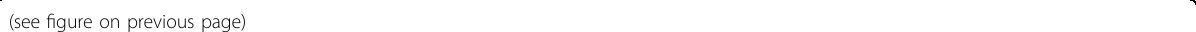
Fig. 4 Maternal PRS- and drug-induced changes in F1 offspring behavior under low- and high-stress testing conditions. a In the OF (left), male F1-PRS rats spend less time in the center of the OF compared to F1-C, regardless of maternal drug treatment (center ; 2 × 3 ANOVA, group F 1,83 = 7.6, p < 0.01), while female offspring are unaffected by maternal PRS or drug treatment (right). b In the NOR task (left), PRS decreases overall exploration time in males (center; 2 × 3 ANOVA, group, F 1,75 = 4.45, p < 0.05), but increases it in females, and the latter effect is reversed by maternal treatment with either NBI or FLX (right; 2 × 3 ANOVA, group × drug F 2,71 = 4.7, p < 0.05) . c In the EPM (left), maternal PRS decreases open arm latency in males (2 × 3 ANOVA, group F 1,76 = 4.9, p < 0.05), and subsequent NBI treatment reverses this effect (center; one-way ANOVA on F1-C/VEH and F1- PRS groups, F 3,47 = 2.9, p < 0.05). In female offspring, maternal PRS increases latency, and subsequent treatment with either NBI or FLX reverses this effect (right; one-way ANOVA on F1-C/VEH and F1-PRS groups, F 3,32 = 2.9, p < 0.05). d On the Acquisition Day (Day 1) of the fear conditioning/ extinction task, (left), maternal PRS decreases freezing during the tone period in male offspring (2 × 3 ANOVA, group F 1,64 = 9.3, p < 0.01), and subsequent drug treatment had no effect (center). In female offspring (right), we observe an interaction that approaches signi fi cance between group and drug treatment (2 × 3 ANOVA, F 2,78 = 3.1, p = 0.052), so that maternal PRS and/or FLX decreased freezing during tone presentation. e During the Context Test (Day 2) (left), maternal PRS decreases freezing in male offspring, and subsequent drug treatment has no effect (center; 2 × 3 ANOVA, group F 1,74 = 10.4, p < 0.01). In female offspring (right), only PRS followed by FLX marginally decreases freezing (2 × 3 ANOVA, group × drug F 2,84 = 3.0, p = 0.055). f During the Tone Test/Extinction (Day 3), gradual extinction of fear is observed in male offspring (repeated-measures ANOVA, tone F 4.4,343.2 = 25.7, p < 0.001), but maternal PRS or drug treatment have no effect on freezing during tones 1 – 3 (Tone Test) or the subsequent 7 tones (Extinction; center). In female offspring (right), freezing is extinguished over time (repeated-measures ANOVA, tone F 4.3, 370 = 20.3, p < 0.0001), maternal FLX treatment decreases freezing during tones 1 – 3 (repeated-measures ANOVA, drug F 2,85 = 4.1, p < 0.05), and marginally decreases freezing in tones 4 – 10 (repeated-measures ANOVA, drug F 2,85 = 3.0, p = 0.055) regardless of maternal PRS exposure. Data presented as individual values, with bars and whiskers representing means and standard errors, respectively ( a – e ), or as means and standard errors ( f ). # p < 0.075, * p < 0.05, ** p < 0.001, post-hoc relative to